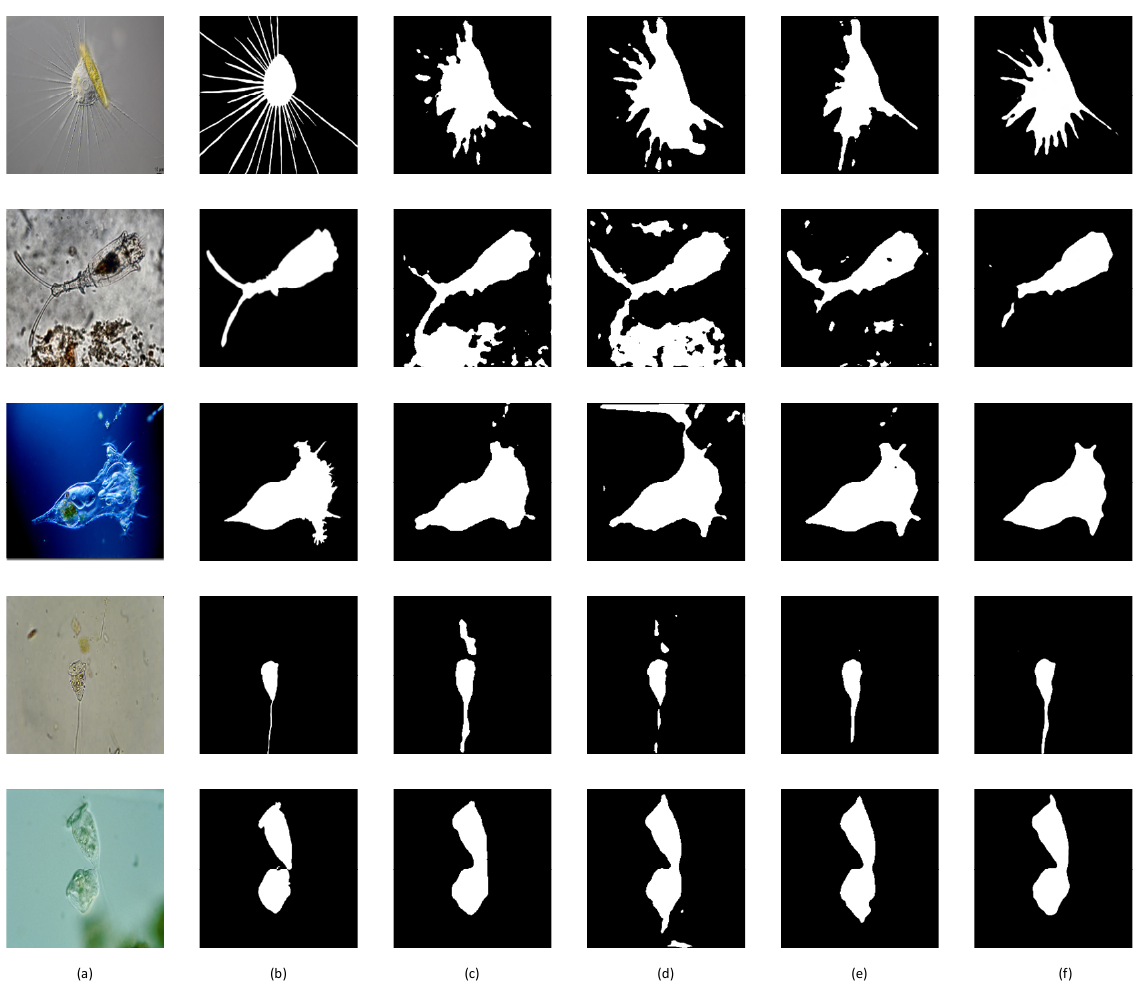
Figure 5. Visual comparison between baseline and improvement. ( a ) Original picture, ( b )